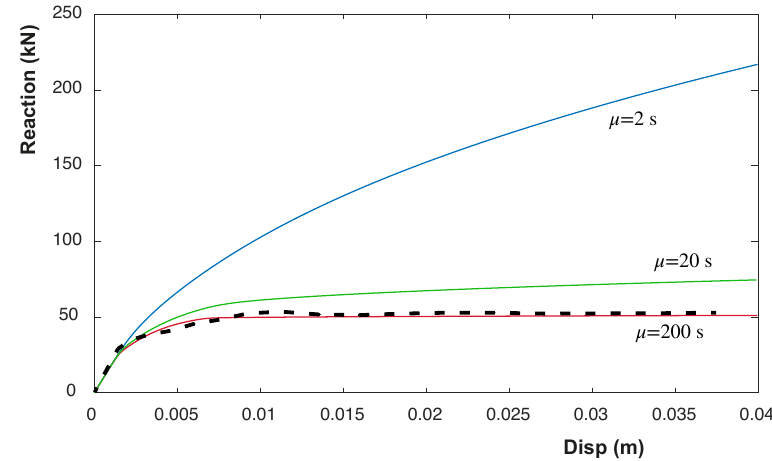
Figure 9. Obtained reaction with different µ values for the problem of the strip footing using visco- plastic von Mises law. The dashed line represents the pseudo-static behavior.